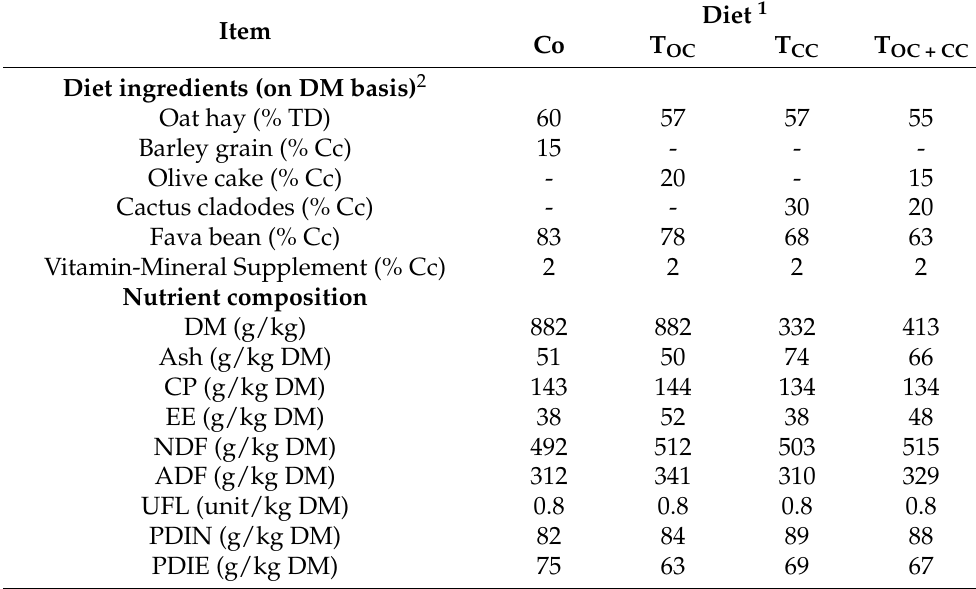
Table 2. Ingredients and chemical composition of the distributed diets.